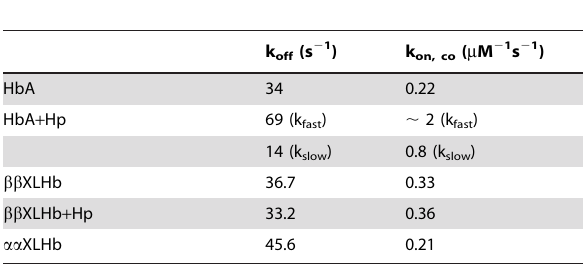
Table 1. Ligand binding kinetic parameters of HbA and bb XLHb in the presence and absence of Hp.